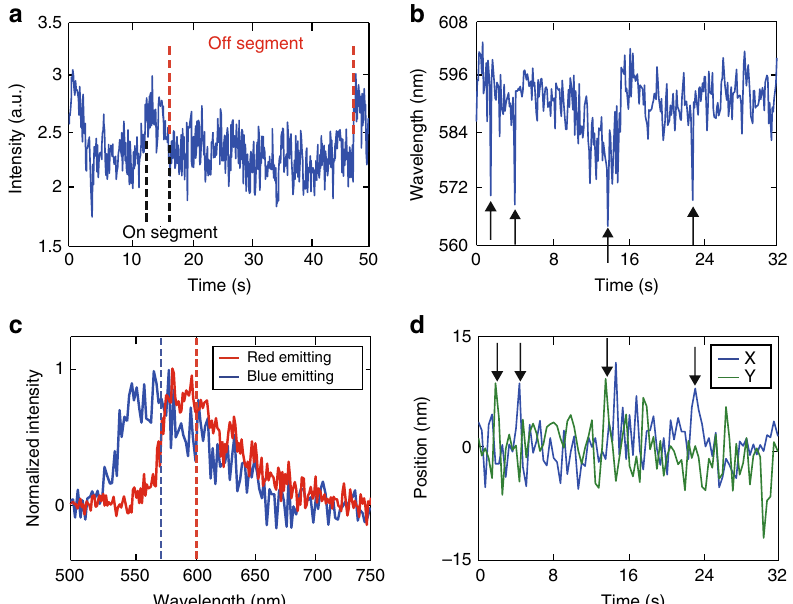
Fig. 4 Polaron hopping between the red and the blue phase. a A fl uorescence intensity trajectory showing two-level blinking. b The spectrum centroid trajectory determined from the off segment in plot a , showing two-level fl uctuations. c Typical difference spectra, showing shifts in the spectrum centroid (indicated by the dashed lines). For this plot, every two pixels along the X axis (wavelength) were binned together to reduce noise. d The X and Y polaron position trajectory obtained during the lower intensity segment in plot a, originally acquired at 50 Hz framerate. For plotting, every 10 points were binned together to reduce noise, both X and Y trajectories were moved to center around 0. Polaron hopping events that occur together with the downward spikes in the spectrum centroid are highlighted by the